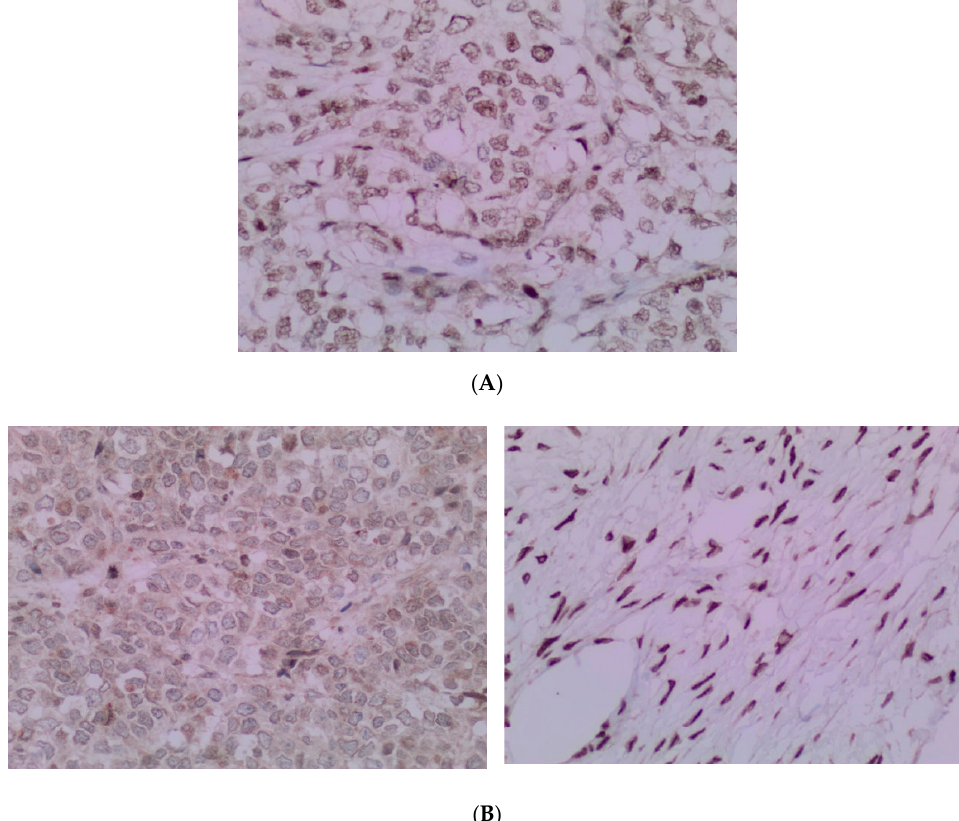
Figure 5. The pathology analysis of the surgical specimen. The stain INI ‐ 1—loss of expression (IHC, 100×).